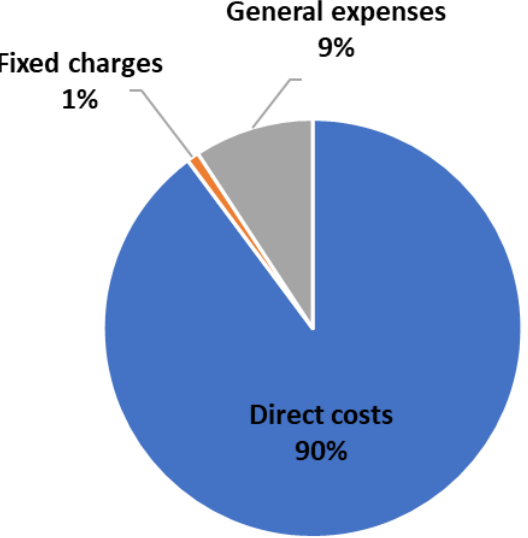
Figure 20. Cost distribution of the total production costs (TPC) of the process MR-based process.